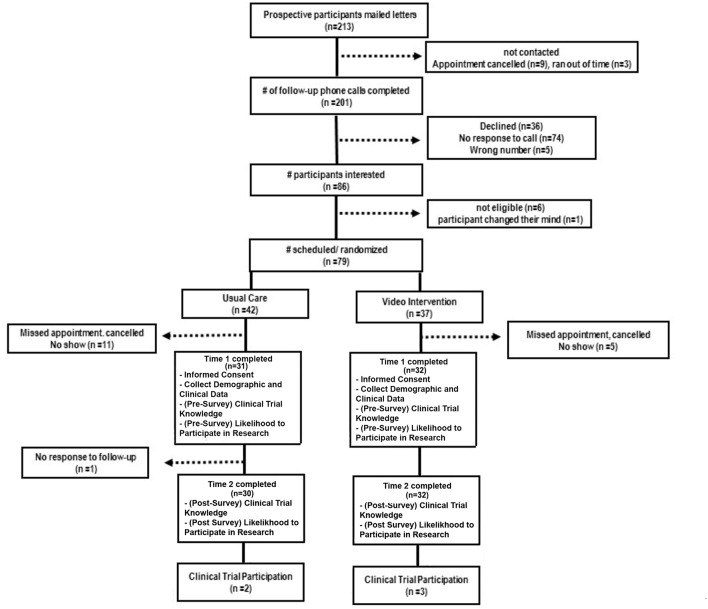
Participant flow.